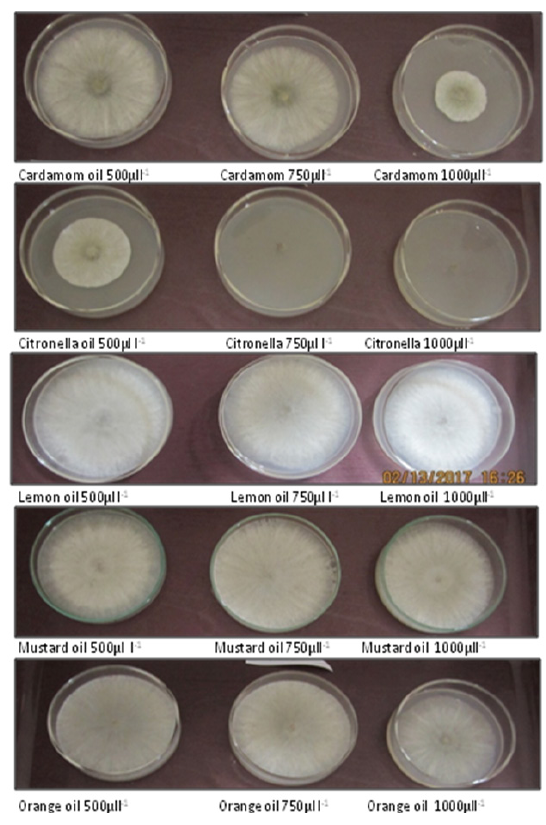
Figure 2: Mycelial inhibition of Colletotrichum sp. isolated from papaya on PDA enriched with different essential oils, 2 days after